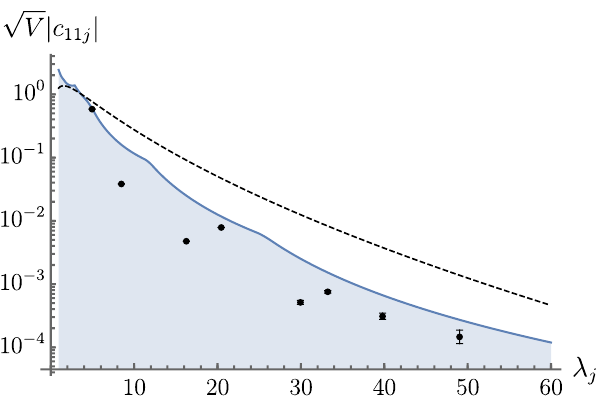
√ Figure 10 . An upper bound on V | c 11 j | for closed hyperbolic surfaces with λ 1 = 0 . 9477 . The filled circles represent the eigenfunctions φ j of the genus-2 surface ρ (5) , defined in eq. (4.16), with j ∈ { 4 , 7 , 16 , 18 , 29 , 33 , 39 , 48 } . The dashed line is the Bernstein-Reznikov bound (5.2) with A 1 = 3 , using V = 4 π